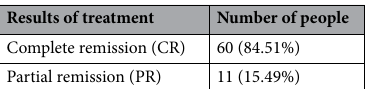
Results of treatment